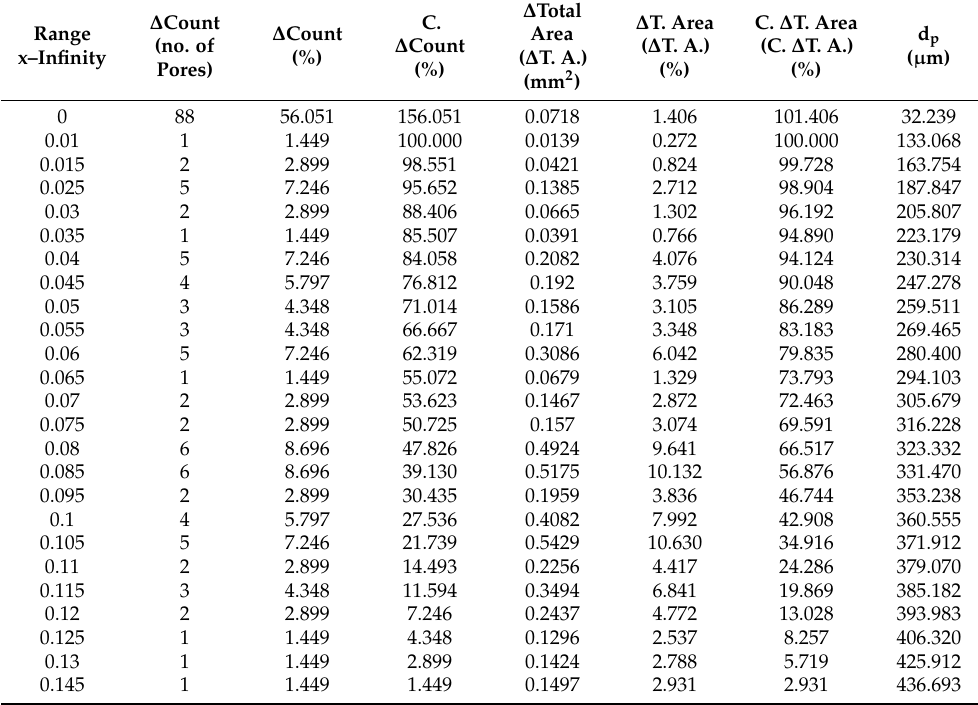
Table A2. Calculation of porosity parameters based on measurements in Table 5.